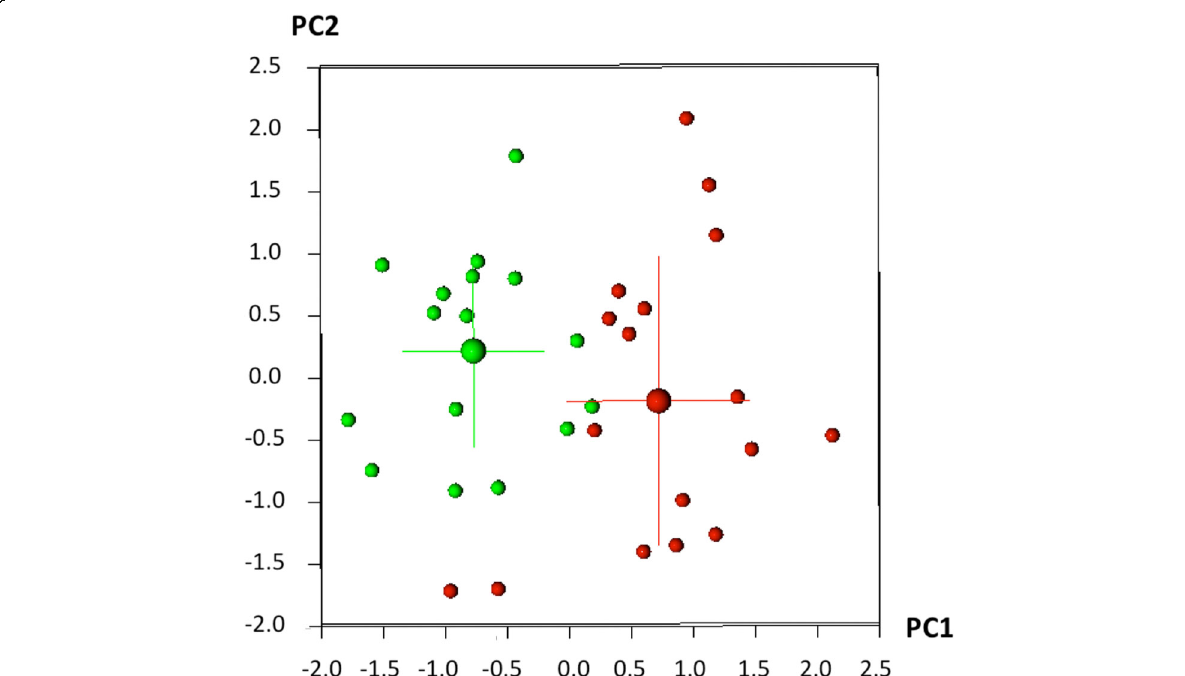
Fig. 2 Clusterized results: in green, nose breather/controls; in red, mouth breathers/patients. On the x -axis PC1, on the y -axis PC2 from Principal